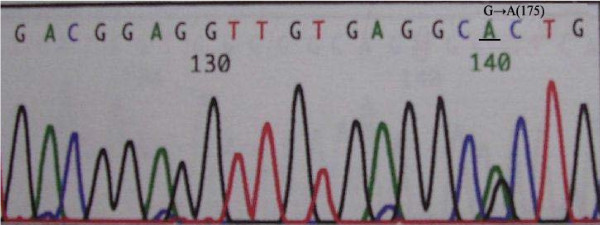
Representative transition of p53 exon 5 (G: C/A: T) found in cholangiocarcinoma.